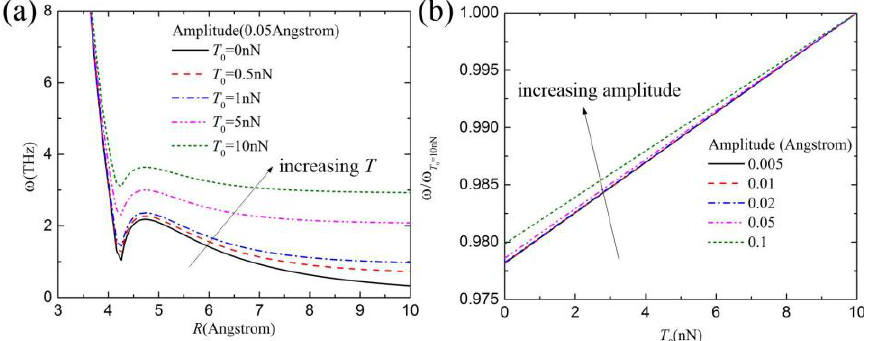
Figure 4. ( a ) The radii effect of SWCNTs on the vibration frequency distribution of a carbon chain in different SWCNTs; ( b ) The effect of the initial tensile force on the normalized vibration frequency distribution of a carbon chain in (5,5) SWCNT.